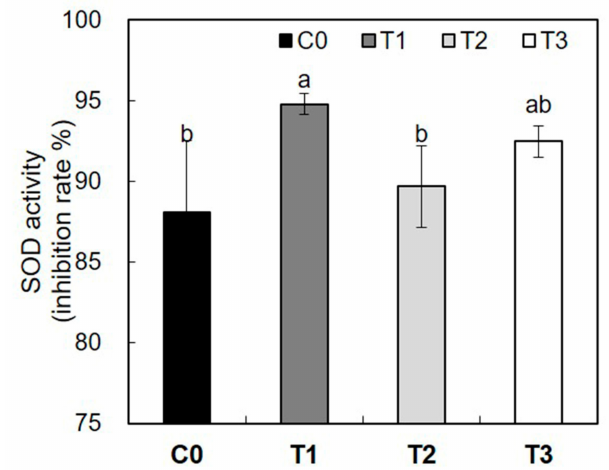
Figure 8. SOD (superoxide dismutase) activity in yellow-poplar leaves exposed to the natural day/night cycle (C0, black bar) and the day/night with artificial lighting cycle (T1, T2, and T3 denote dark gray bar, light gray bar, and white bar, respectively). Data indicate mean ± SD ( n = 5). Different lowercase letters on the bars indicate significant differences among treatments (Tukey’s test after one-way